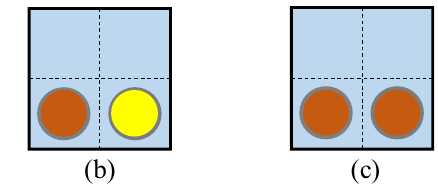
Figure 1. Multi-cell geometries. Table I. Dimensions of pin